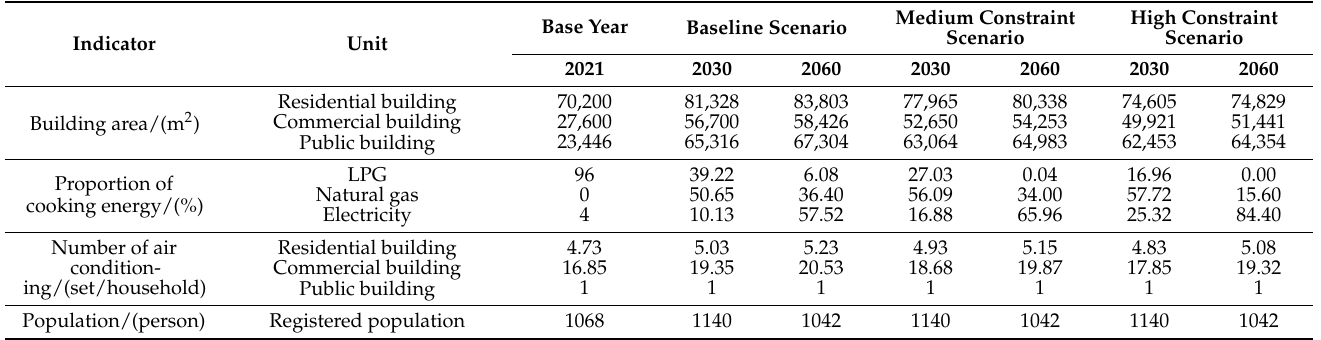
Table 3. LEAP model parameters of village Y in the benchmark